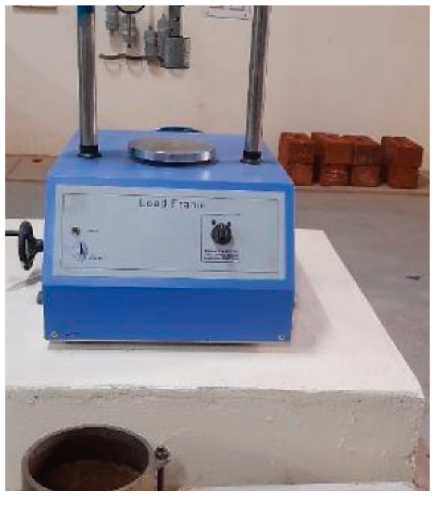
Figure 4: CBR test